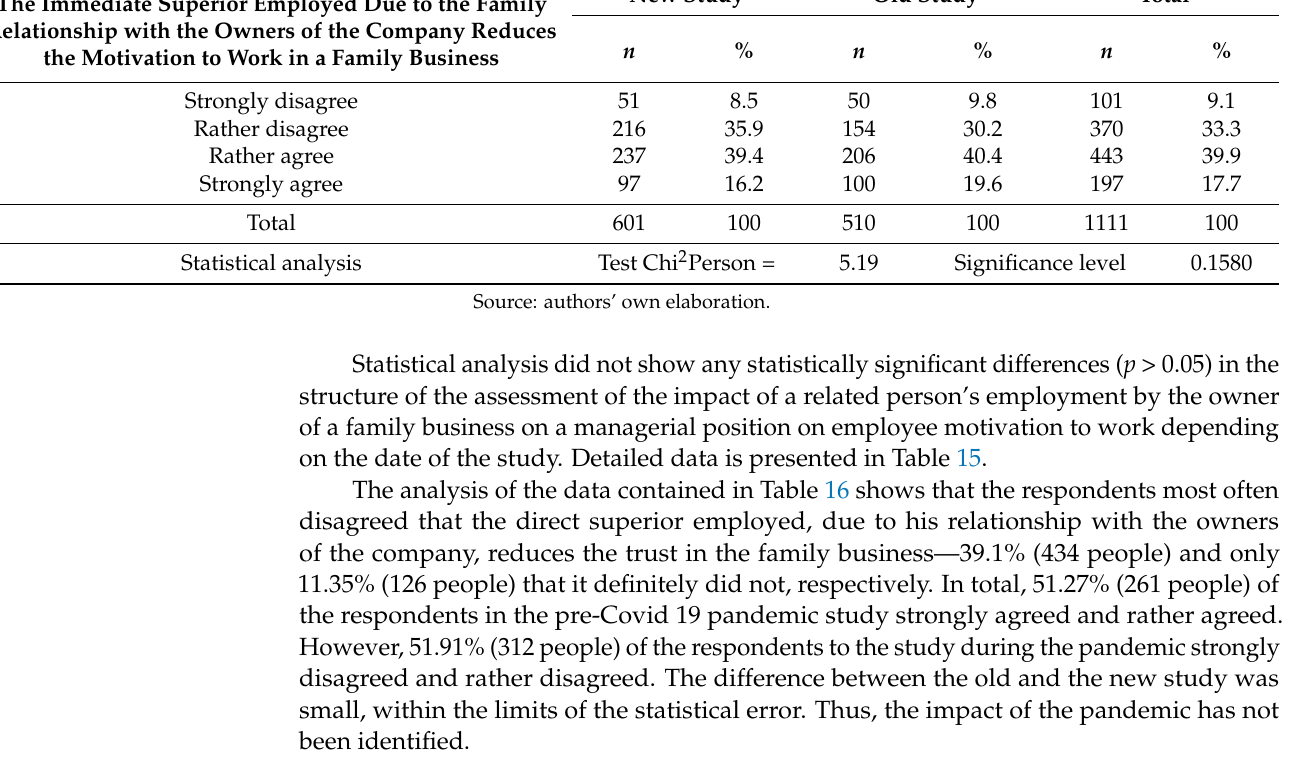
Table 15. Statistical analysis of the assessment of the impact of the employee’s immediate superior due to the relationship with the owners of the company on the motivation to work in a family business depending on the date of the study. The Immediate Superior Employed Due to the Family